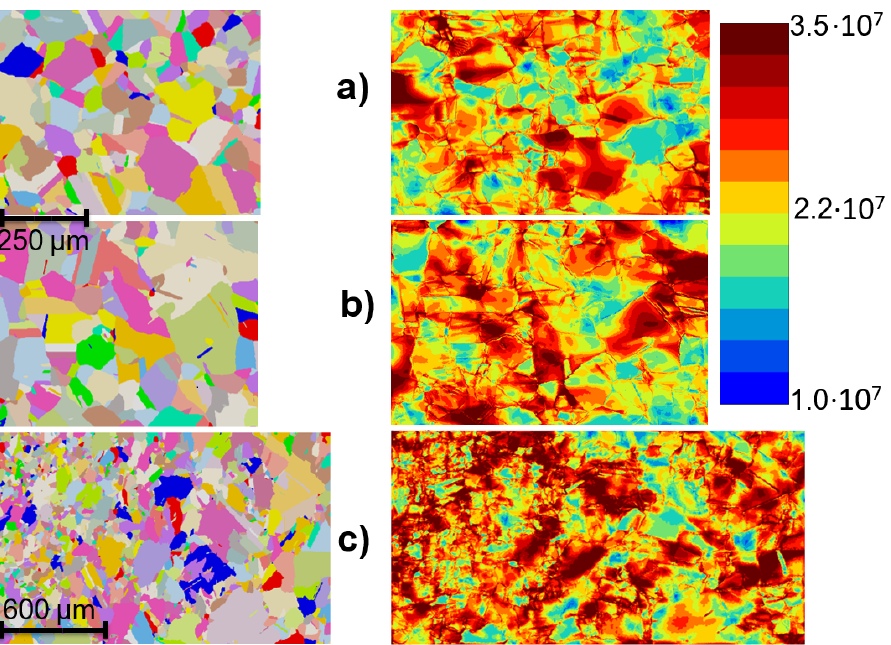
Figure 4. Grain morphology maps (grains colored with random colors) and total dislocation density